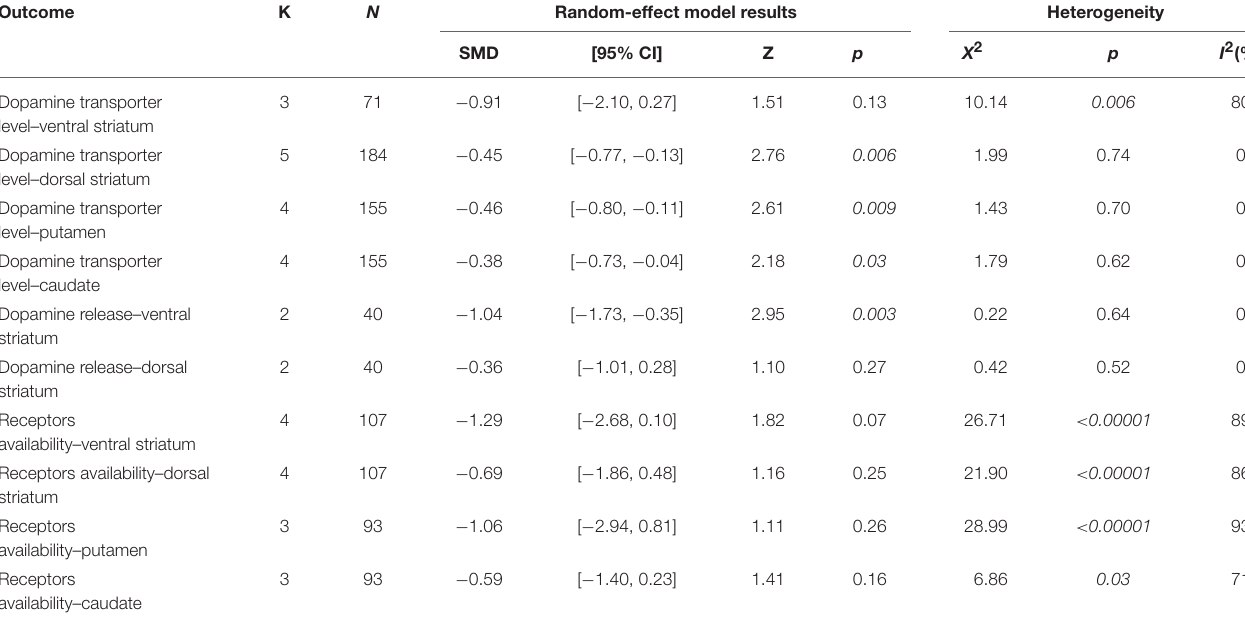
TABLE 4 | Results of the